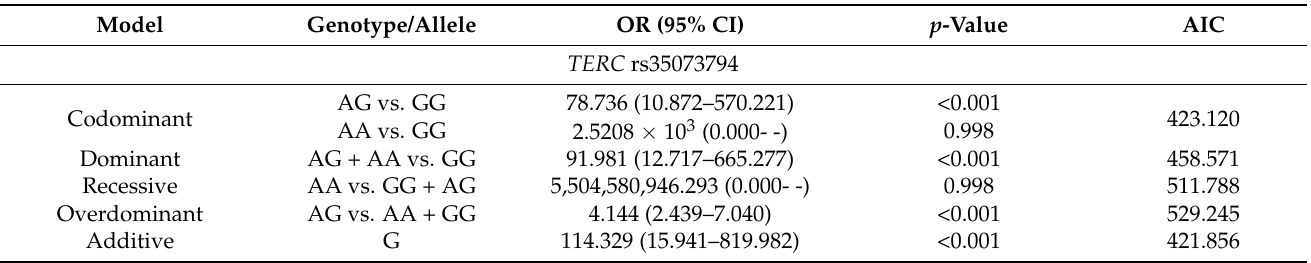
Table 3. Binary logistic regresion analysis within patients with pituitary adenoma and control group subjects.